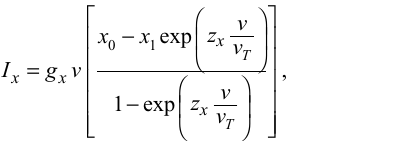
∈ {0.1, 0.5, 0.9} using the general formulation (solid lines) and its cubic K < 1 / 2 and outward rectification for b K